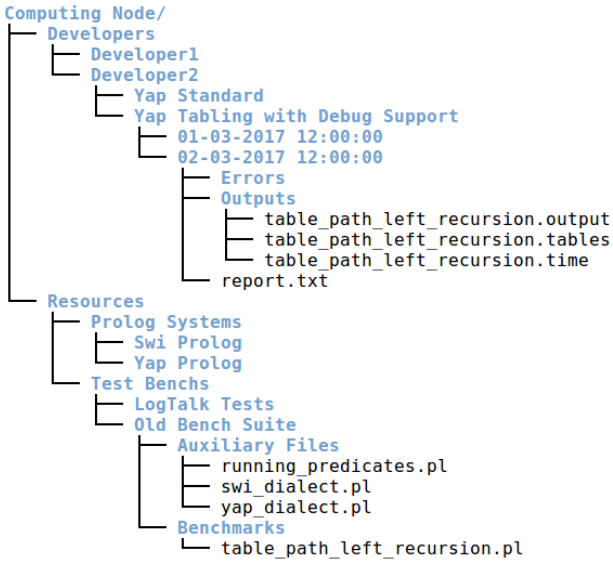
Figure 5. Working space of a computing